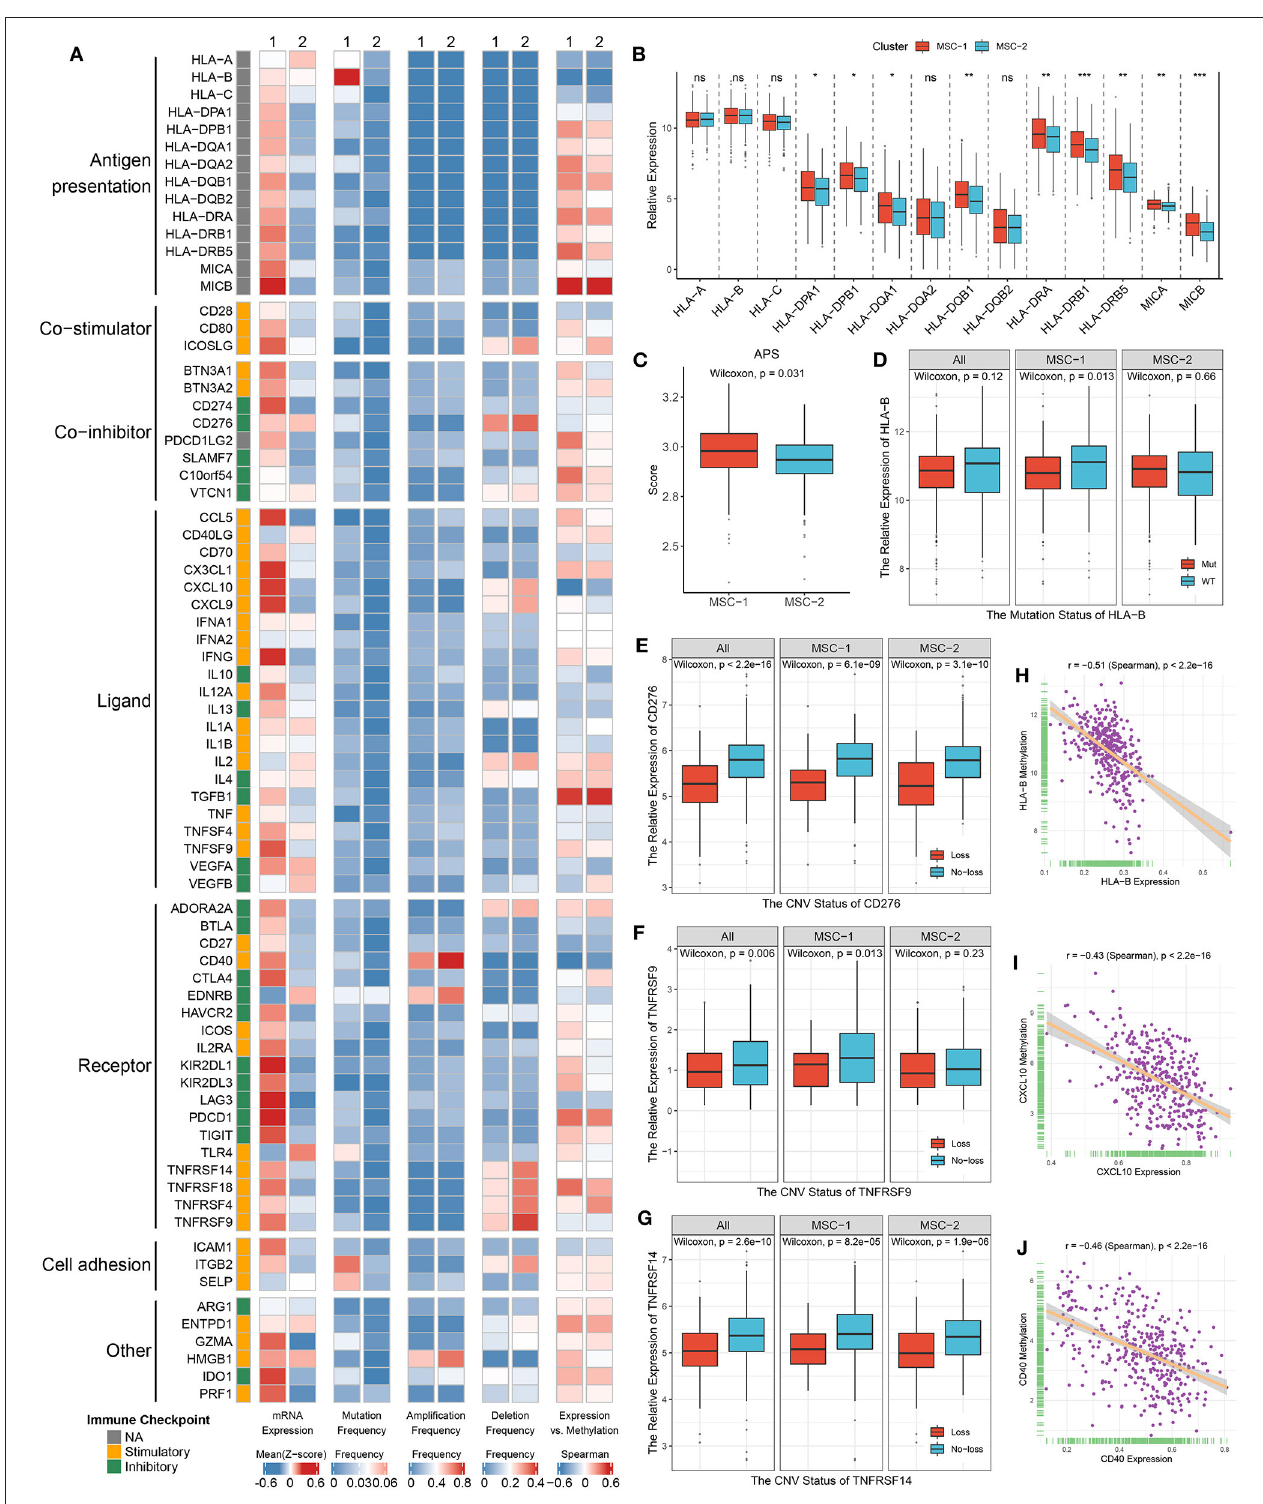
FIGURE 6 | Multi-omics analysis of 75 immunomodulators in the TCGA-CRC cohort. (A) From left to right: mRNA expression (z-score), mutation frequency, amplification frequency, deletion frequency, and expression vs. methylation (gene expression correlation with DNA-methylation beta value) of 75 immunomodulators in MSC-1 and MSC-2. (B) The expression difference of MHC molecules between two subtypes. ns, P > 0.05; * P < 0.05; ** P < 0.01; *** P < 0.001. (C) The distribution of APS score in MSC-1 and MSC-2. (D–G) The expression difference of HLA-B (D) between the mutant and wild groups, as well as CD276 (E) , TNFRSF9 (F) , and TNFRSF14 (G) between loss and no-loss groups. (H–J) The correlation analysis between the methylation and mRNA expression levels of HLA-B (H) , CXCL10 (I) , and CD40 (J) .